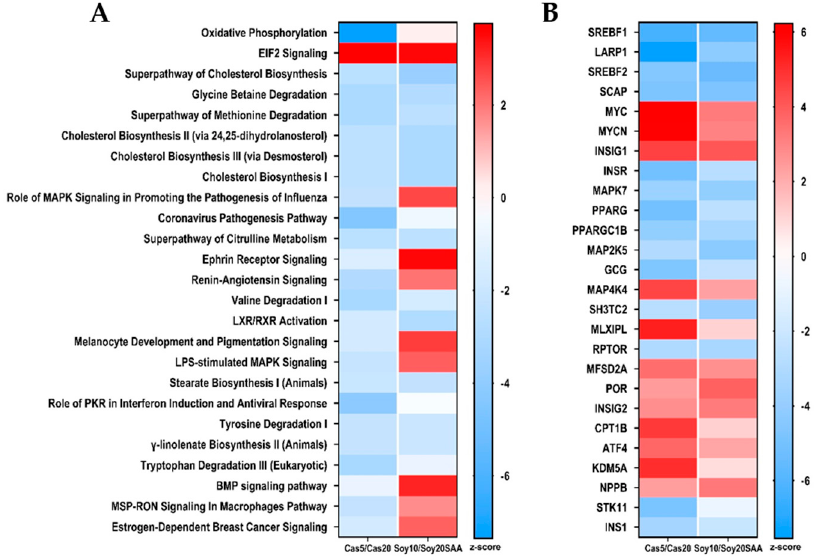
Figure 3. Bioinformatics analysis of hepatic gene expression in mice fed sulfur amino acid-matched control diets formu- lated from casein (Cas-20%) or soy (Soy-20% + SAA), and sulfur amino acid-matched protein restricted diets formulated from casein (Cas-5%) or soy (Soy-10%). Canonical pathway analysis ( A ) and upstream regulator analysis ( B ) were con- ducted as described in the Materials and Methods. Pathway analysis was conducted using livers from 6 mice of each diet and utilized to identify putative gene regulators responsible for the observed transcriptional patterns produced by the respective protein-restricted diets. Upstream regulators and canonical pathways with an activation z-score ≥ 2 or ≤ − 2 were considered to be activated (red) or inhibited (blue), respectively. Heat maps were used to visualize the top 25 canonical pathways and upstream regulators that were differentially affected by the MR diet in the two genotypes.